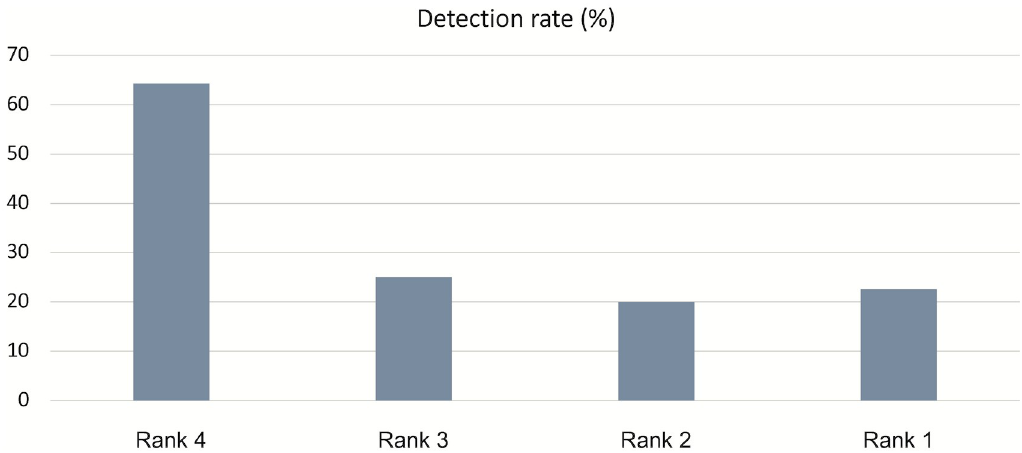
Fig 2. Results of the positive rates of each drug group calculated to validate the algorithm.